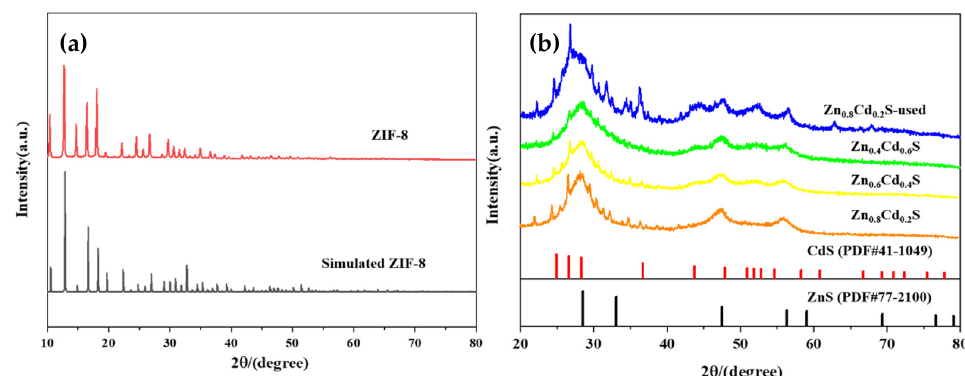
Figure 3. XRD of (a) ZIF-8 and ZnS, and (b) different metal ratios of Zn 1-x Cd x S.